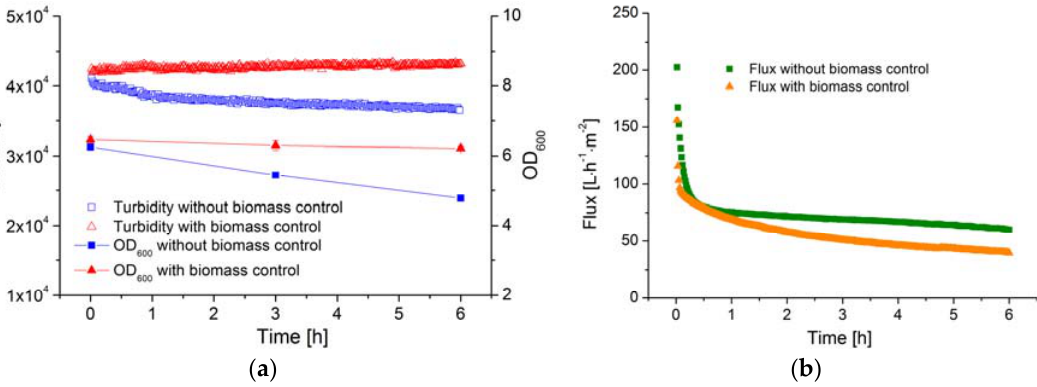
Figure 7. ( a ) The biomass concentration in the fermentation broth during filtration, with and without glucose feeding; OD values are means ± standard deviation ( n = 3). ( b ) The filtration flux of the fermentation broth during filtration, with and without glucose feeding, membrane: ceramic hollow fiber membrane, TMP: 0.6 bar, CFV: 2 m·s − 1 .